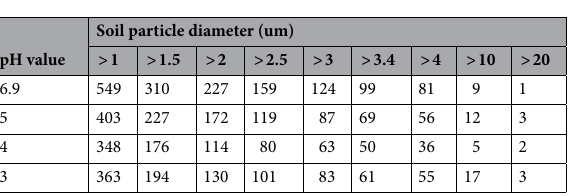
Table 1. The number of particles on the particle diameter at different pH